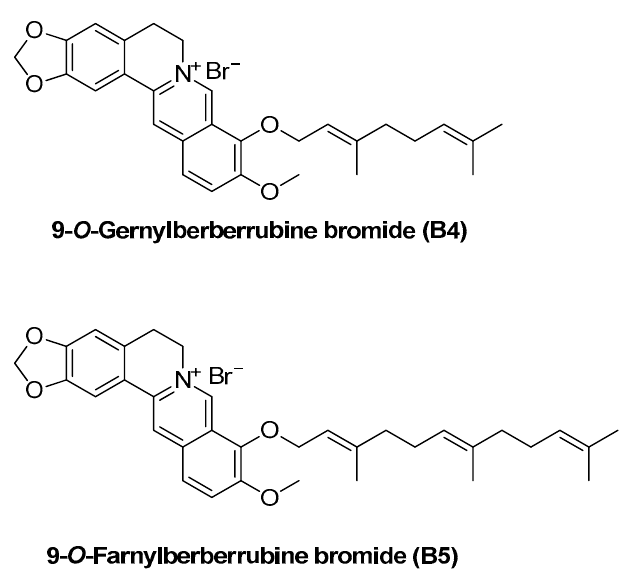
Figure 1. Chemical structures of berberine as well as berberrubine and derivatives. Table 1. The IC 50 of berberine, berberrubine and its derivatives in human non-small-cell lung cancer cells.